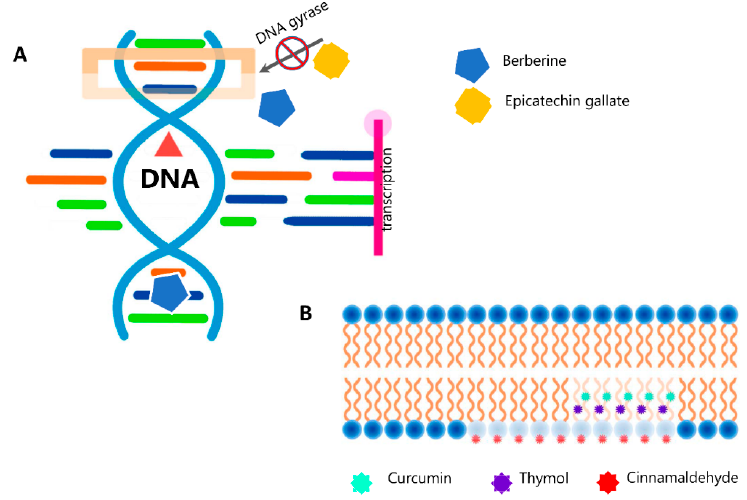
Figure 2. Antimicrobial action of secondary metabolites of plants (SMoPs). ( A ). E ff ect of SMoPs on